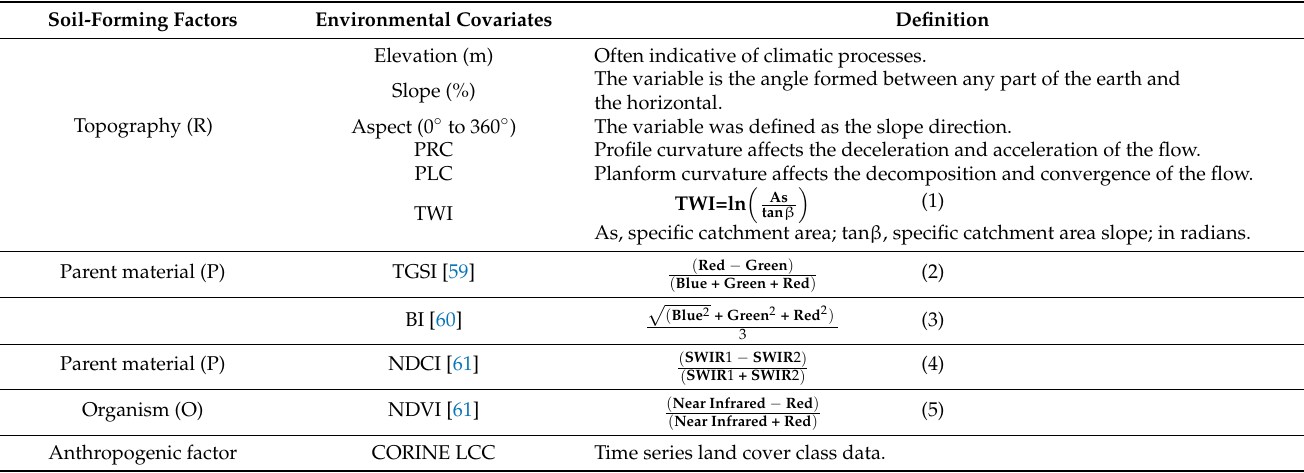
Table 1. Environmental covariates used in this